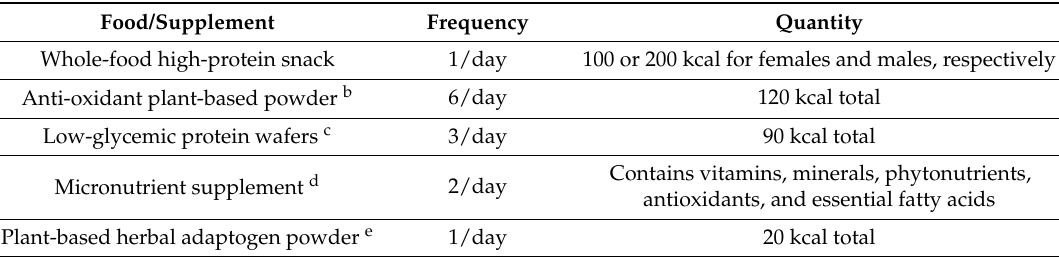
Table 2. Composition of intermittent-fasting day diet during WL Phase 1 a . Food/Supplement Frequency Quantity 1/day 100 or 200 kcal for females and males,